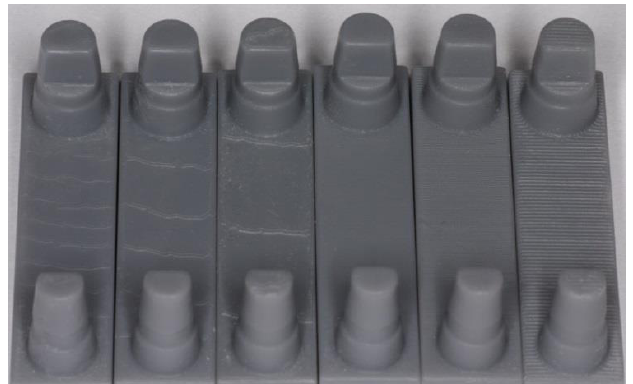
Figure 7. Printed models (from left: 0° and 25, 50, 100 µm; 15° and 25, 50, 100 µm). The distinct staircase-effects were found in models of lower resolution (100 µm, 3rd and 6th model from left). Models printed at 15° inclination at highest resolution showed best surfaces (25 µm, 4th from left).